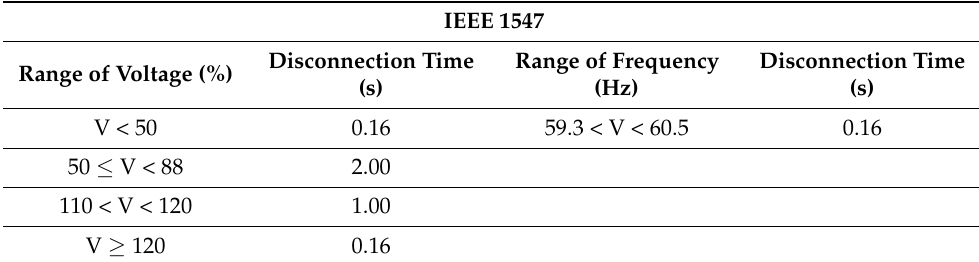
Table 2. Disconnection time for voltage and frequency